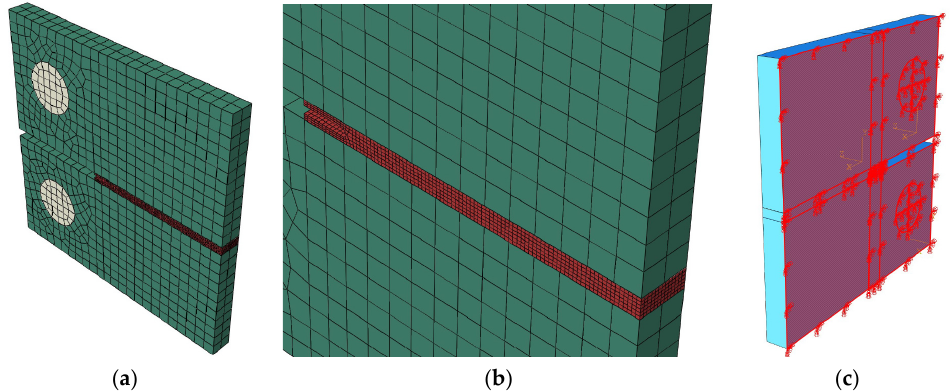
Figure 5. Adopted 3D mesh ( a ), magnification of the proposed UMAT area ( b ), and symmetry conditions ( c ) for the CT test. Table 1. Material properties for the pultruded GFRP material used in the CT tests.